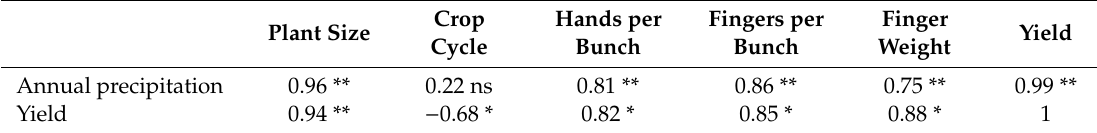
Table 10. Pearson’s correlation coe ffi cients ( r ) between the annual precipitation and plant characteristics of Mchare. Crop Hands per Fingers per Finger Yield Plant Size Cycle Bunch Bunch Weight Annual precipitation 0.96 ** 0.22 ns 0.81 ** 0.86 ** 0.75 ** 0.99 ** Yield 0.94 ** − 0.68 * 0.82 * 0.85